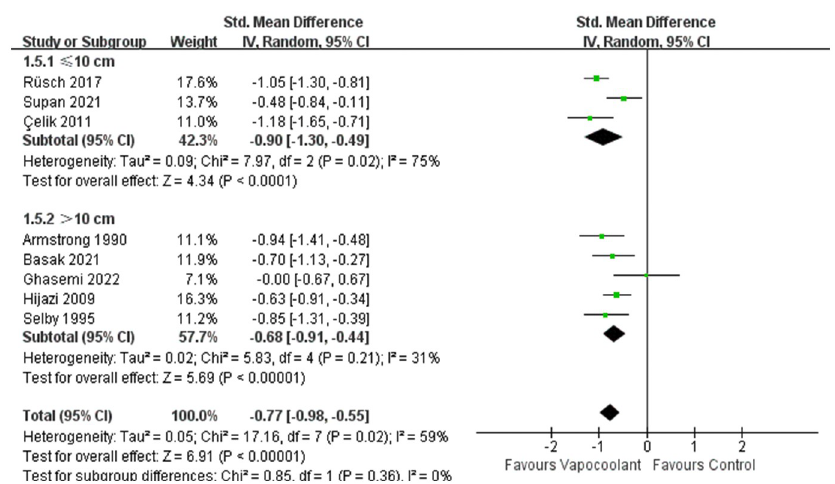
Fig 6. Subgroup analysis of pain scores during intravenous cannulation: Vapocoolants spray distance � 10cm vs > 10cm.